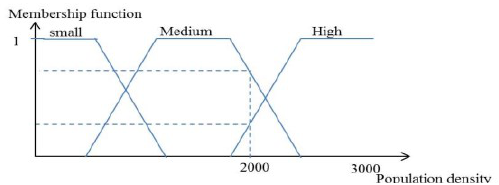
Figure 4. Fuzzy representation of population density